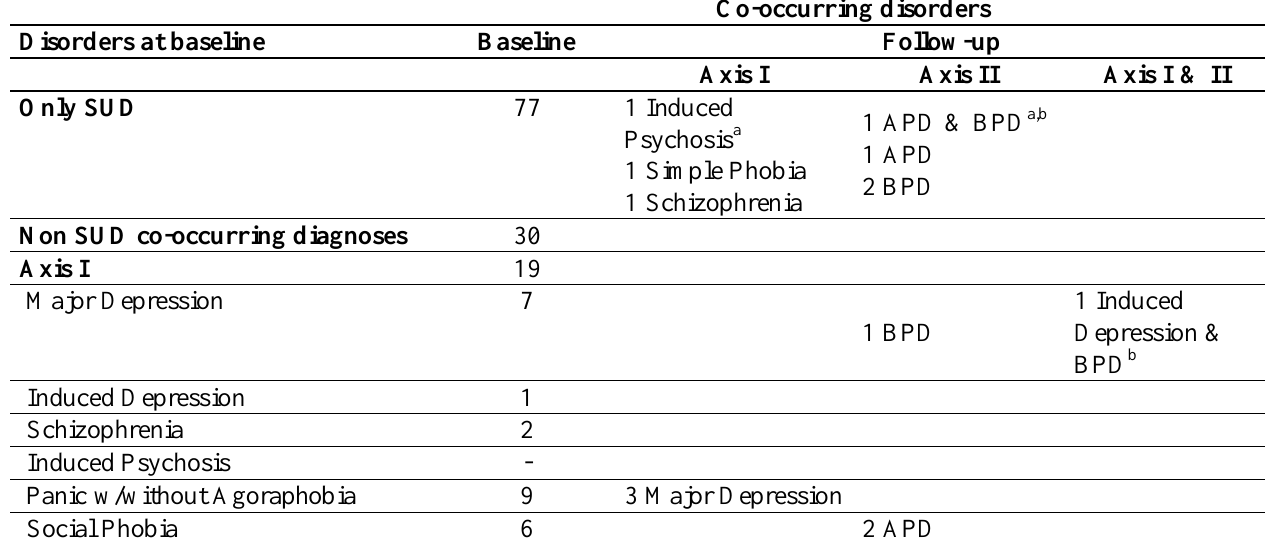
Table 2. Co-occurring disorders incidence in a cohort of 107 patients reassessed at 18